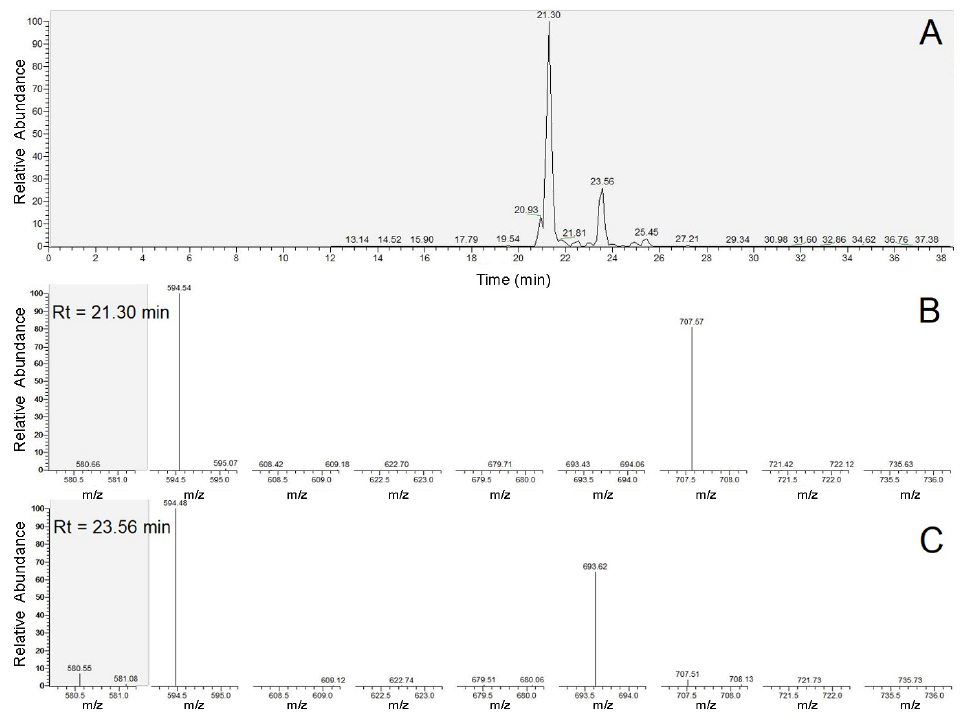
Figure 3. The extracted ion chromatogram (EIC) of m/z = 1016.7 of B. velezensis strain SZMC 24983 ( A ), and the MS 2 spectra of the peaks at Rt = 21.30 min ( B ) and Rt = 23.56 min ( C ).